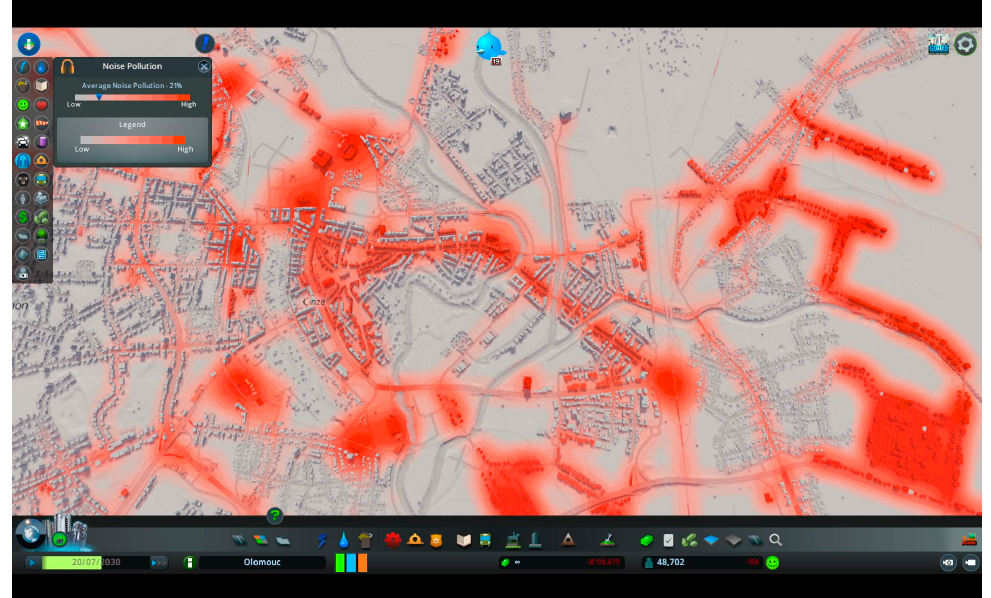
Figure 10. Simulated noise pollution in the Cities: Skylines’ model of Olomouc.